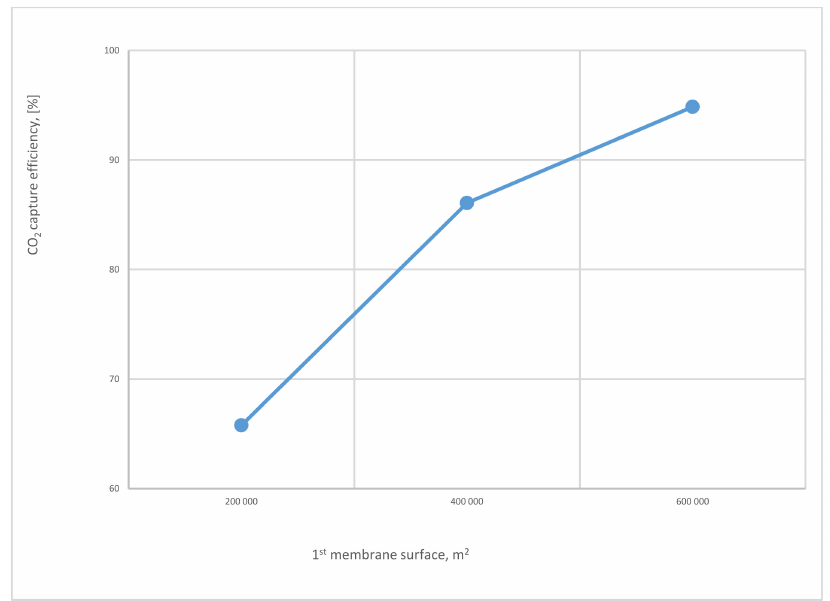
Figure 15. The 1st membrane surface effect on CO 2 capture efficiency for 2-stages of the membrane at 8 bar of 1st compressor pressure, 4 bar of 2nd compressor pressure, and 40,000 m 2 of 2nd membrane surface.